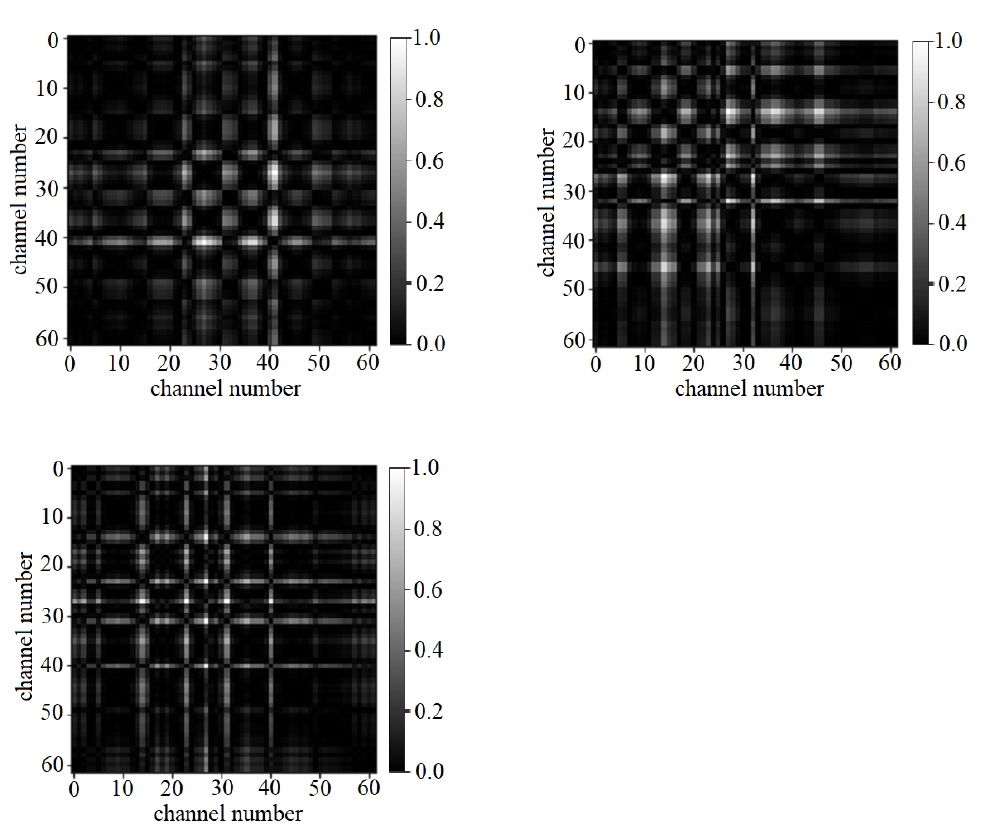
Figure 2. AsMap of gamma band on a slot corresponding to positive, negative, and neutral emo- tion